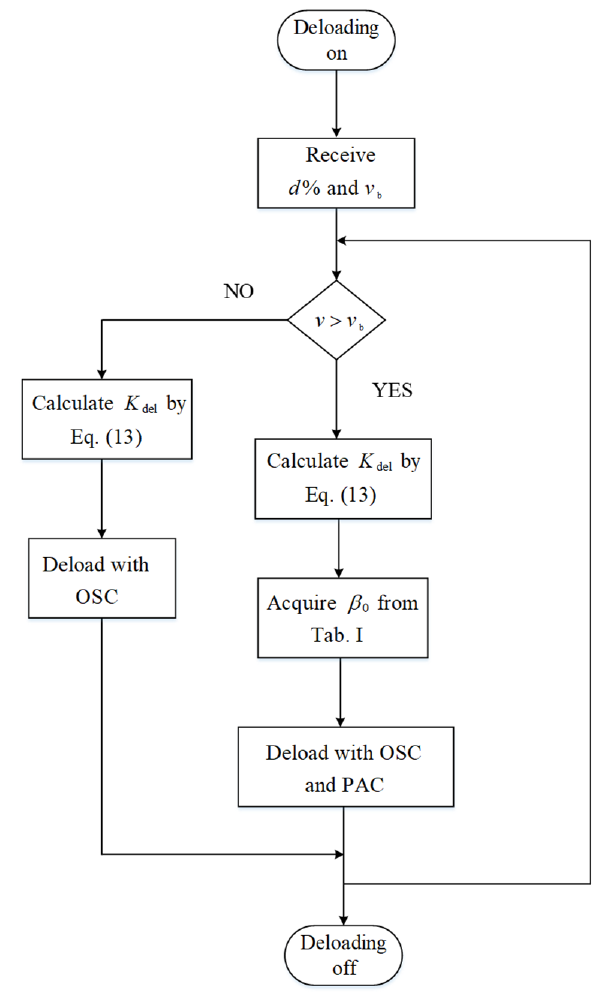
Figure 4. Algorithm of the CDS.